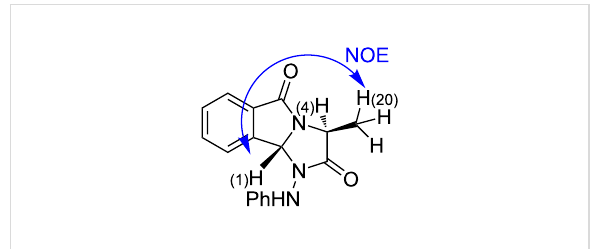
Figure 2: NOEs correlation showing the stereochemistry of the com- pound 5a .